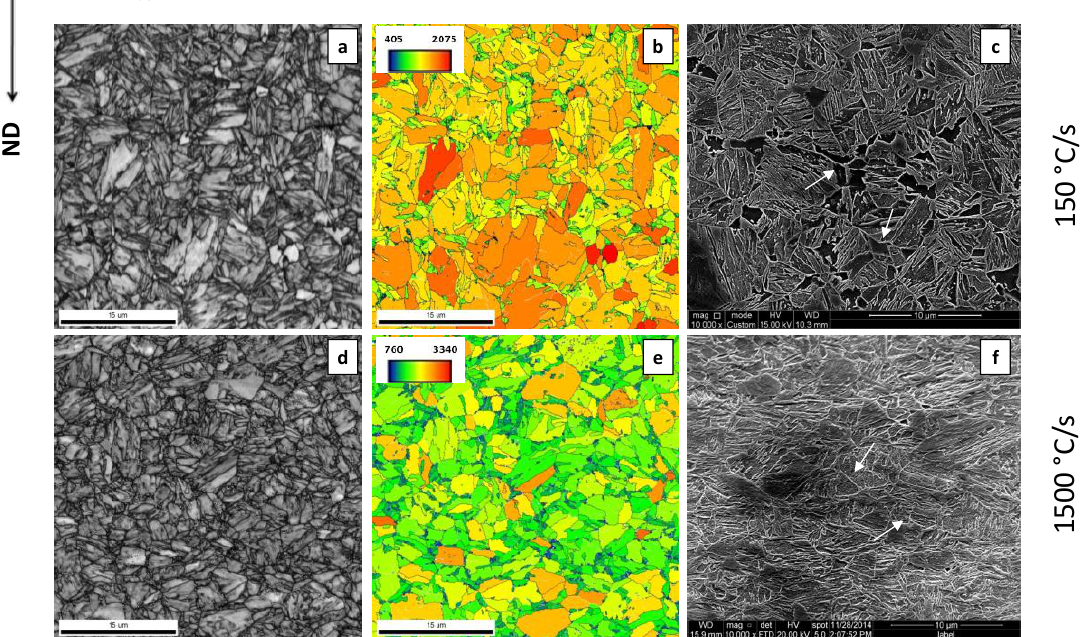
Figure 5. ( a , d ) and ( b , e ) are respectively the IQ and GAIQ maps of a samples heated at 150 °C/s and 1500 °C/s to a peak temperature of ~1000 °C and quenched. ( c , f ) are SEM images of a sample heated at 150 °C/s and at 1500 °C/s to a peak temperature of ~1000 °C and quenched, showing a mixture of martensite and ferrite (white arrows) at parent austenitic grain boundaries. In ( b , e ), high carbon martensite is represented by the blue-green grains, whereas low carbon martensite is represented by light green-yellow grains. Ferrite grains are colored in orange-red.